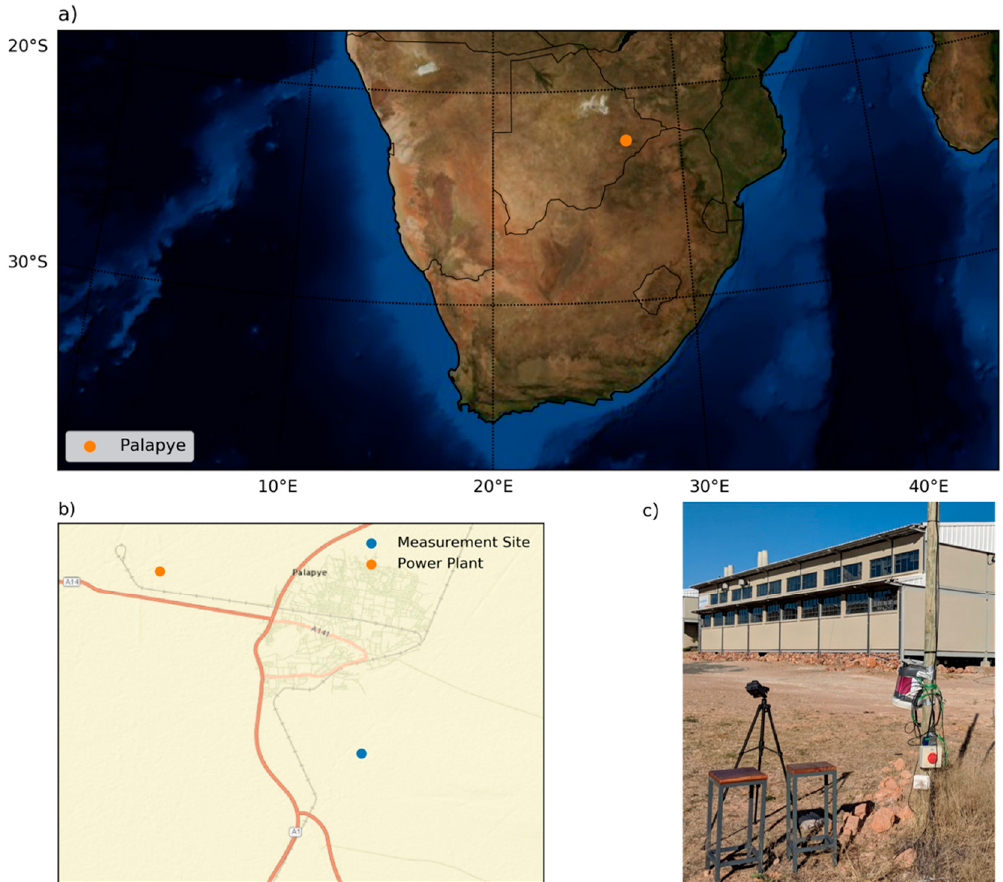
Figure 1. ( a ) Location of Palapye within Botswana. ( b ) Map of Botswana International University of Science and Technology (BIUST) campus relative to the village of Palapye, the A1 Highway, and the Morupule power station (mean winds are east-north-easterly). ( c ) Photograph of the experimental setup with the CEAMS Aerosol Mass and Optical Depth (AMOD) on the black tripod, the Radiello Passive Ammonia sampler under the bucket and the AethLabs MicroAethalometer TM mounted to the wooden utility pole. Map generated using World Street Maps (credit: Esri, HERE, Garmin, USGS, Intermap, INCREMENT P, NRCan, Esri Japan, METI, Esri China-Hong Kong, NOSTRA, ©